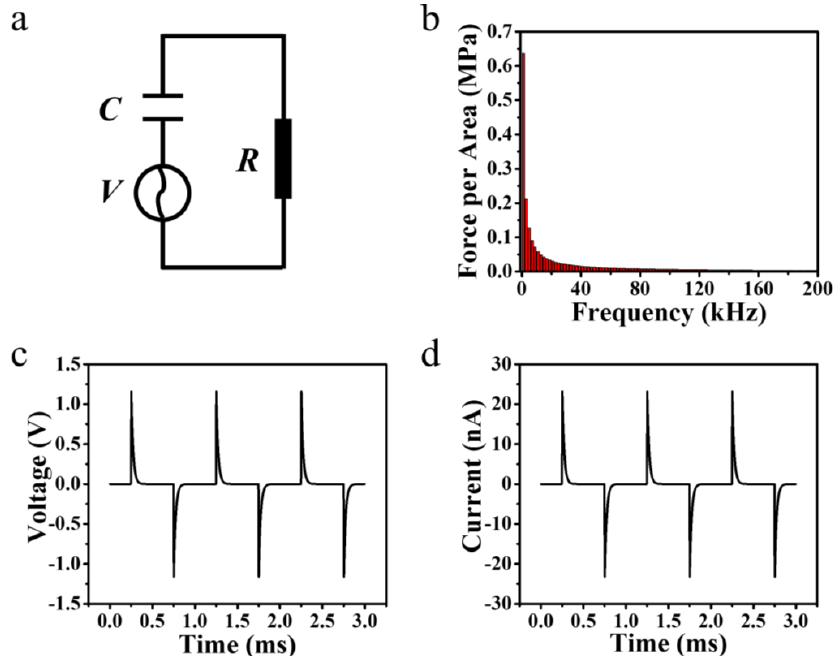
Figure 5. ( a ) The equivalent circuit of the composite PENG. ( b ) The spectral analysis of the square wave force. The output voltage ( c ) and current ( d ) at an external load with a resistance of 50 MΩ.